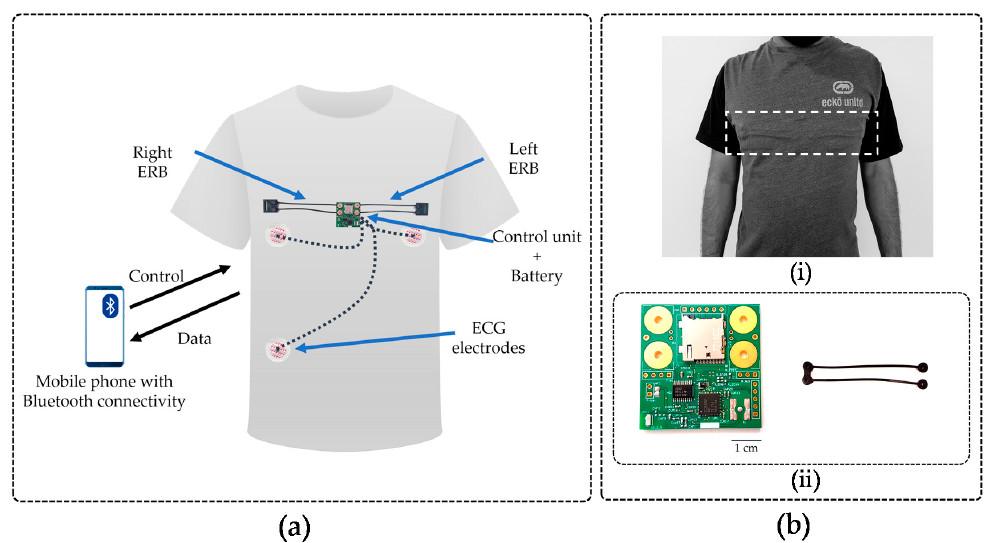
Figure 1. ( a ) Abstract view of the system design highlighting the location of the printed circuit board (PCB), U-shaped sensor band, and ECG electrodes. ( bi ) External view of VitalCore prototype when electronics and sensors are attached to the rear side of the fabric using interfacing. The dashed box highlights the region where the electronics are placed. ( bii ) Top side of the PCB and the U-shaped carbon black conductive rubber sensor. The PCB shows the microcontroller unit (MCU), Bluetooth antenna, analogue to digital converter (ADC), secure digital (SD) cardholder and four placeholders to connect two electroresistive bands (ERBs).